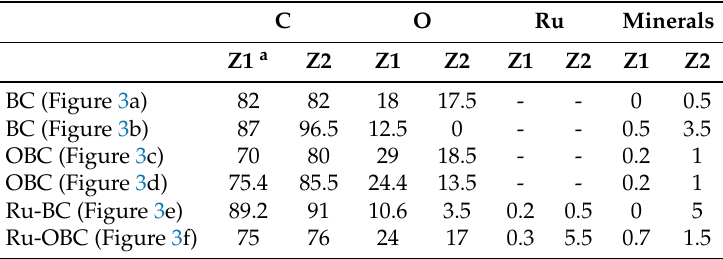
Table 4. EDX Analyses (Atomic Percentages).